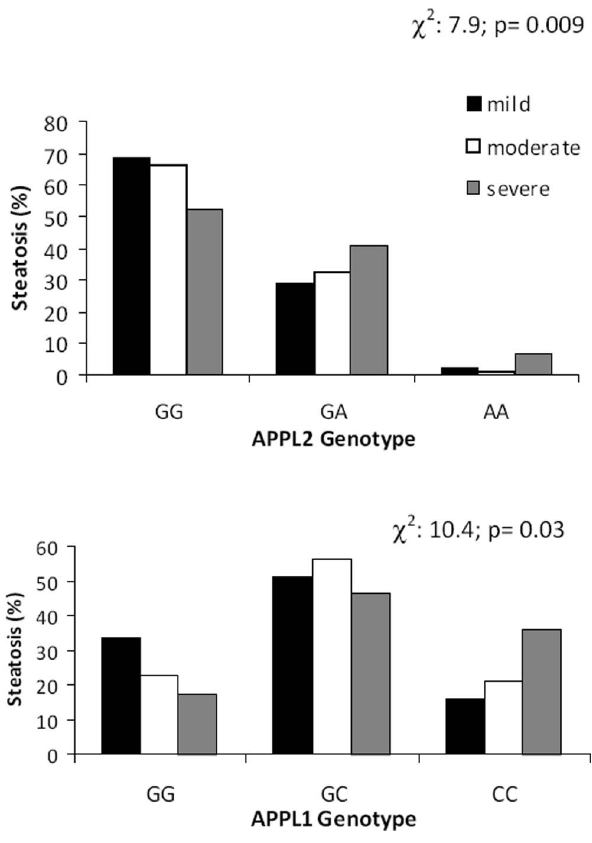
Figure 1. Hepatic steatosis severity among APPL1 and APPL2 genotype groups.